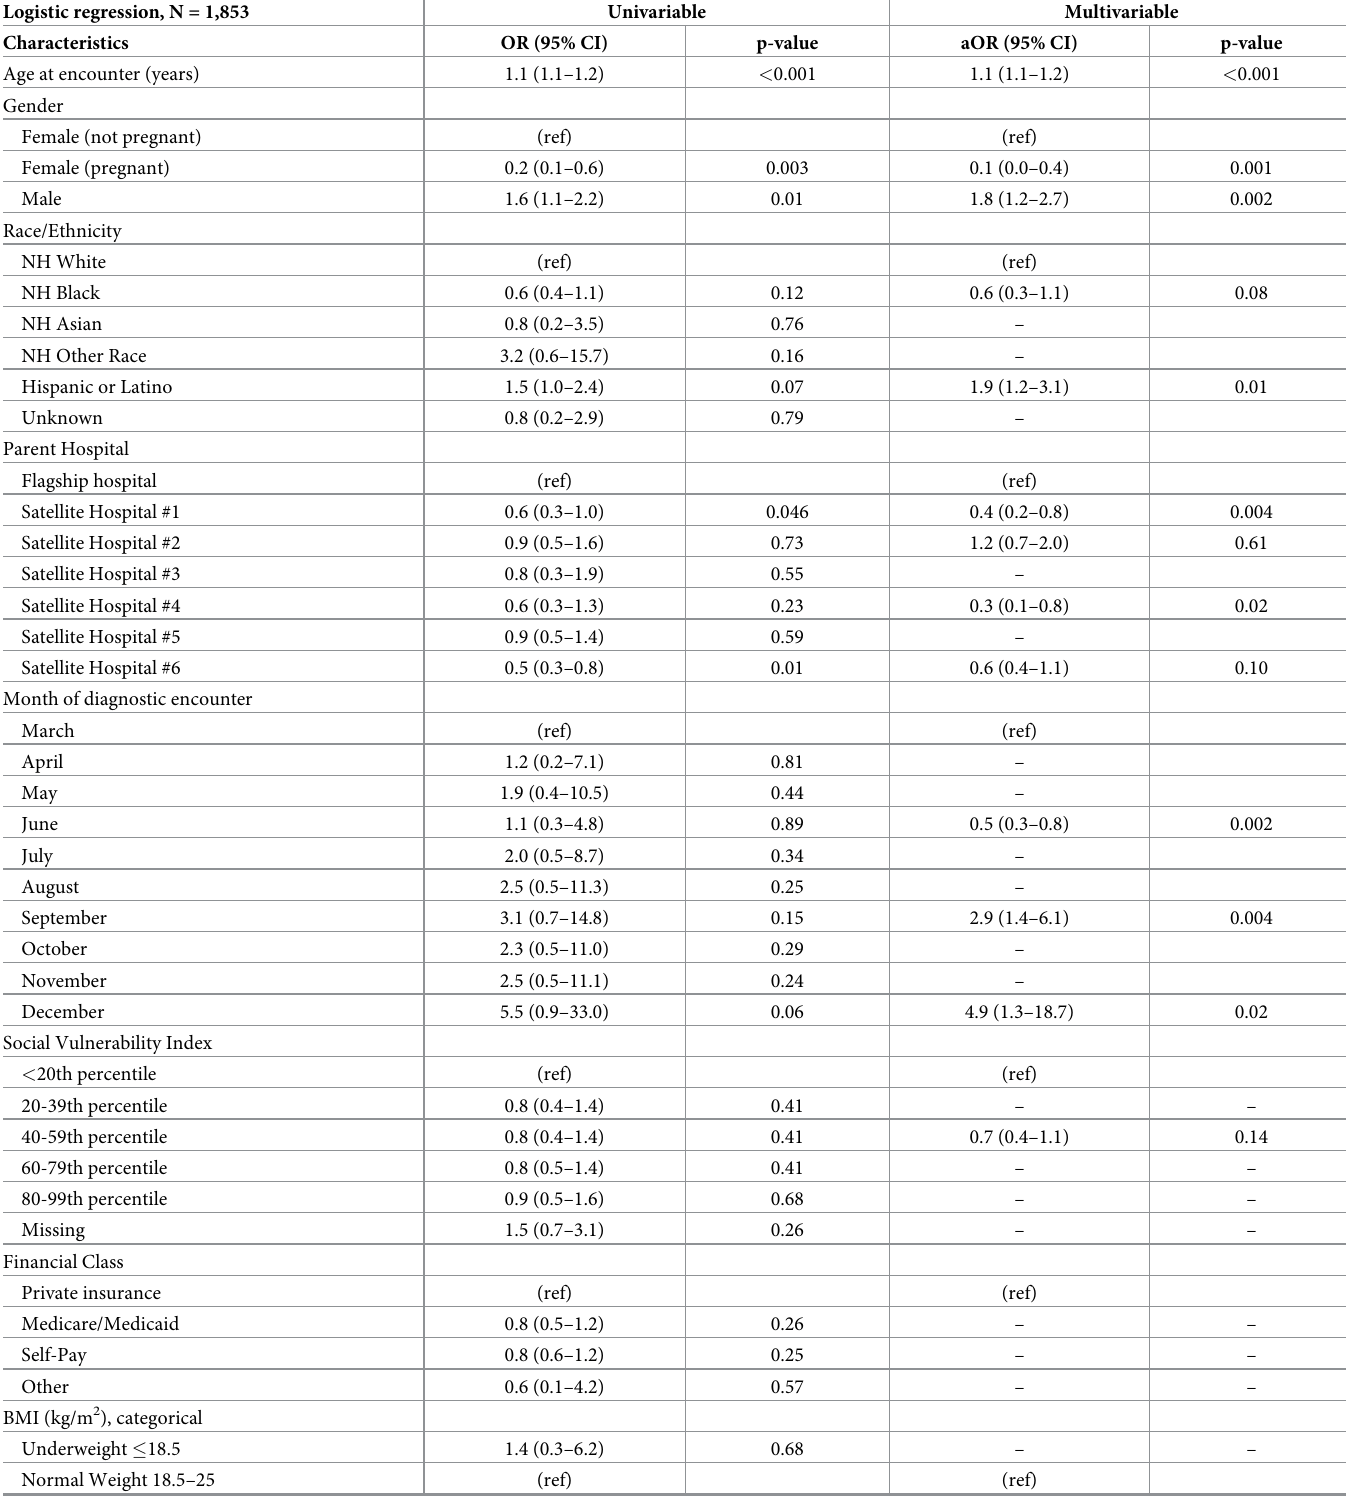
Table 4. Risk factors for composite disease outcomes among COVID-19 patients 18–29 years, diagnosed at a hospital